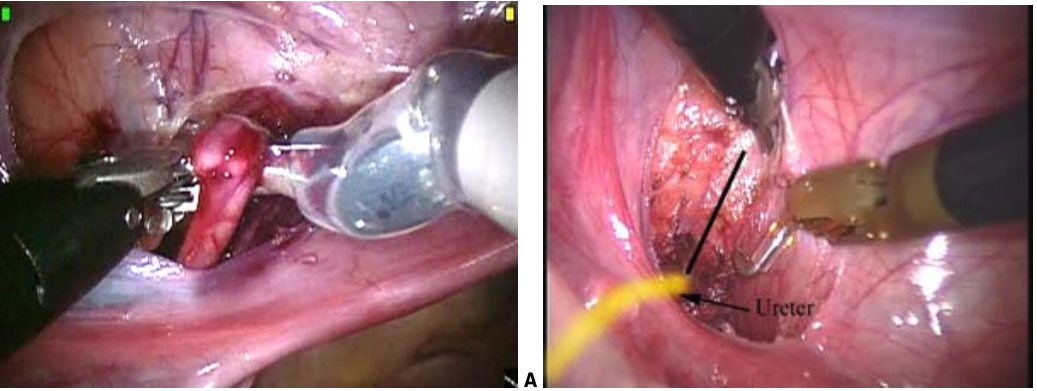
FIGURE 5. (A) Appearance of the ureter being mobilized during an extravesical, ureteral reimplantation performed with robotic assistance. The hook cautery is lifting the ureter to permit blunt dissection of the periureteral tissues. (B) The path of the ureter, which has been mobilized, is depicted in yellow. The location of the detrusor trough that will be created is indicated by the